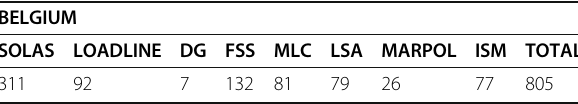
Table 5 Total detainable items for